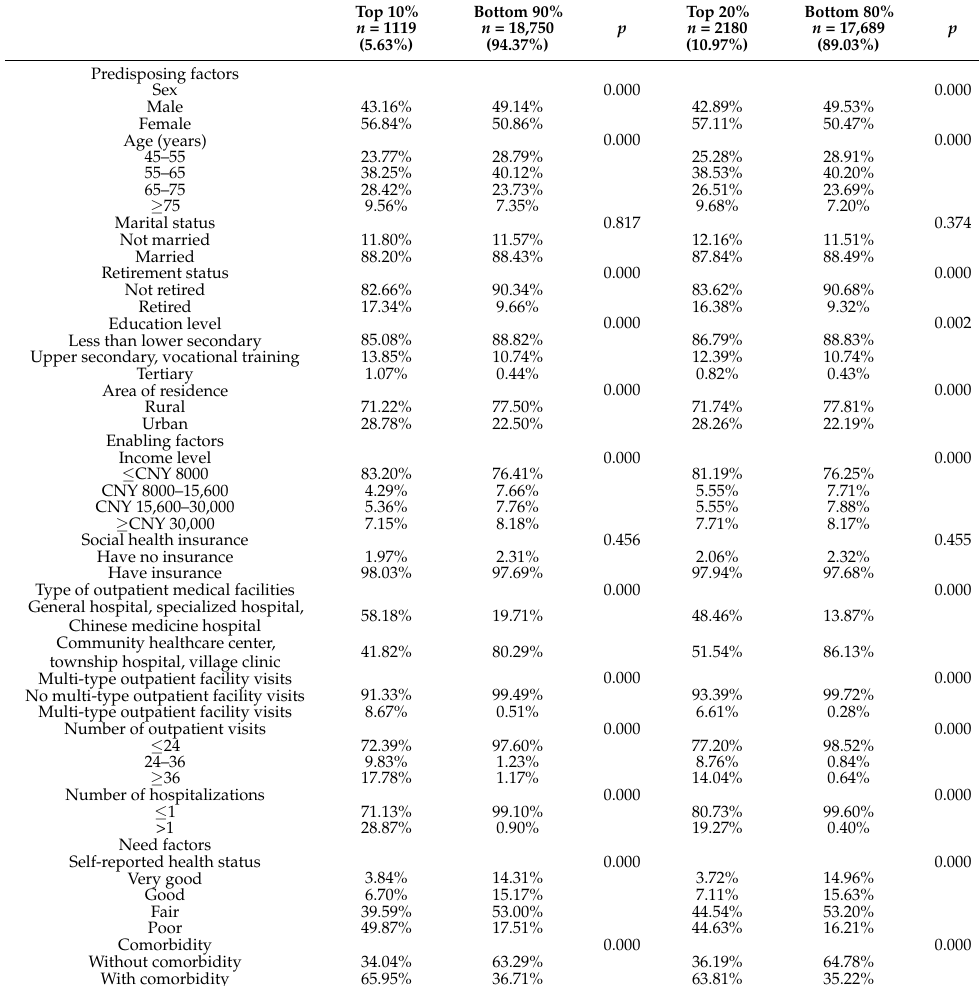
Table 2. Characteristics of middle-aged and elderly participants with the top 10% and 20% of medical expenses.